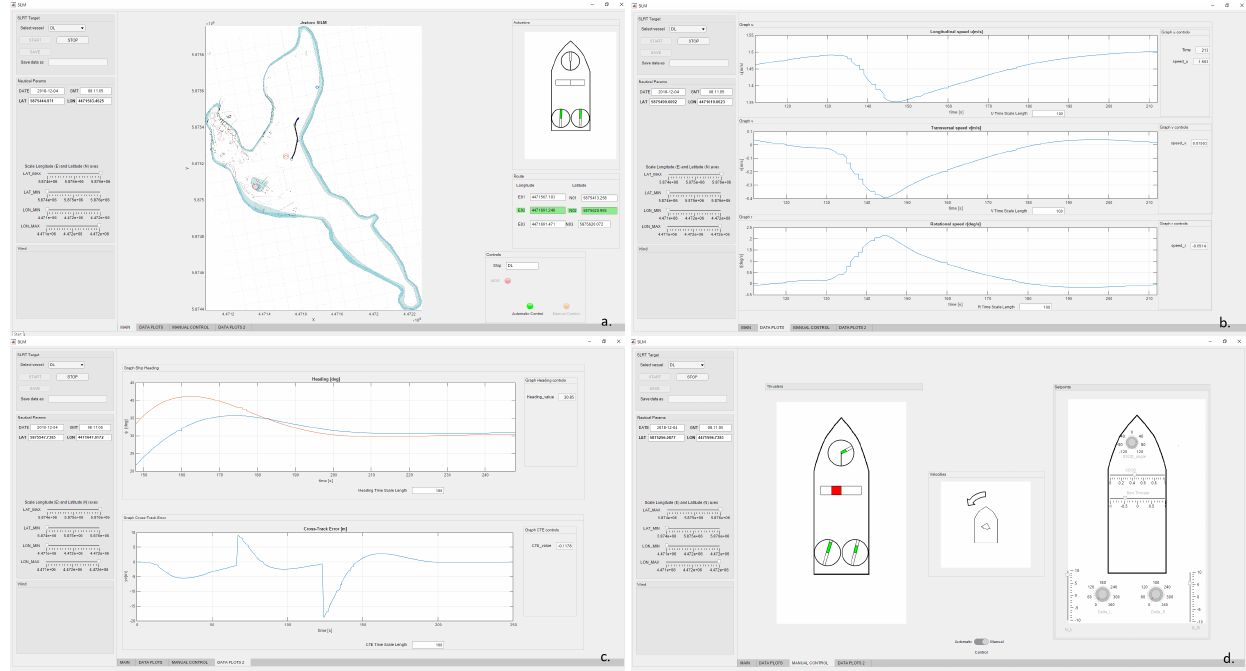
Figure 8. Screenshots of the autonomous training ship control system user interface (Autonomous Training Ship (ATS) Graphical User Interface). ( a ) GUI main screen with map. ( b ) Time histories of ship velocities. ( c ) Time histories of heading and cross-track error. ( d ) Thrusters’ activities display and manual set-point